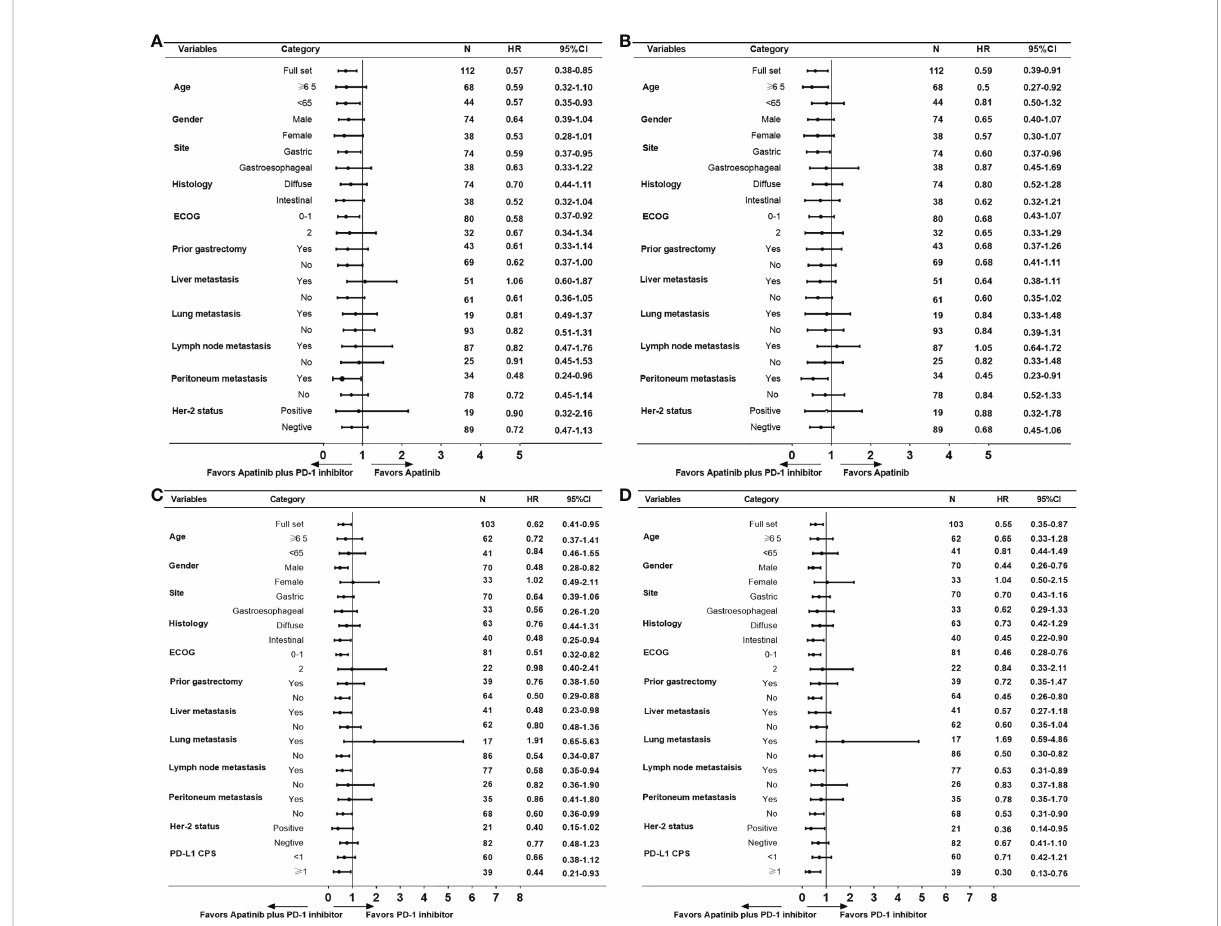
FIGURE 3 Subgroup analyses for PFS and OS. (A) PFS and (B) OS for apatinib plus PD-1 mAb versus apatinib monotherapy. (C) PFS and (D) OS for apatinib plus PD-1 mAb versus PD-1 mAb. PFS, progression-free survival. OS, progression-free